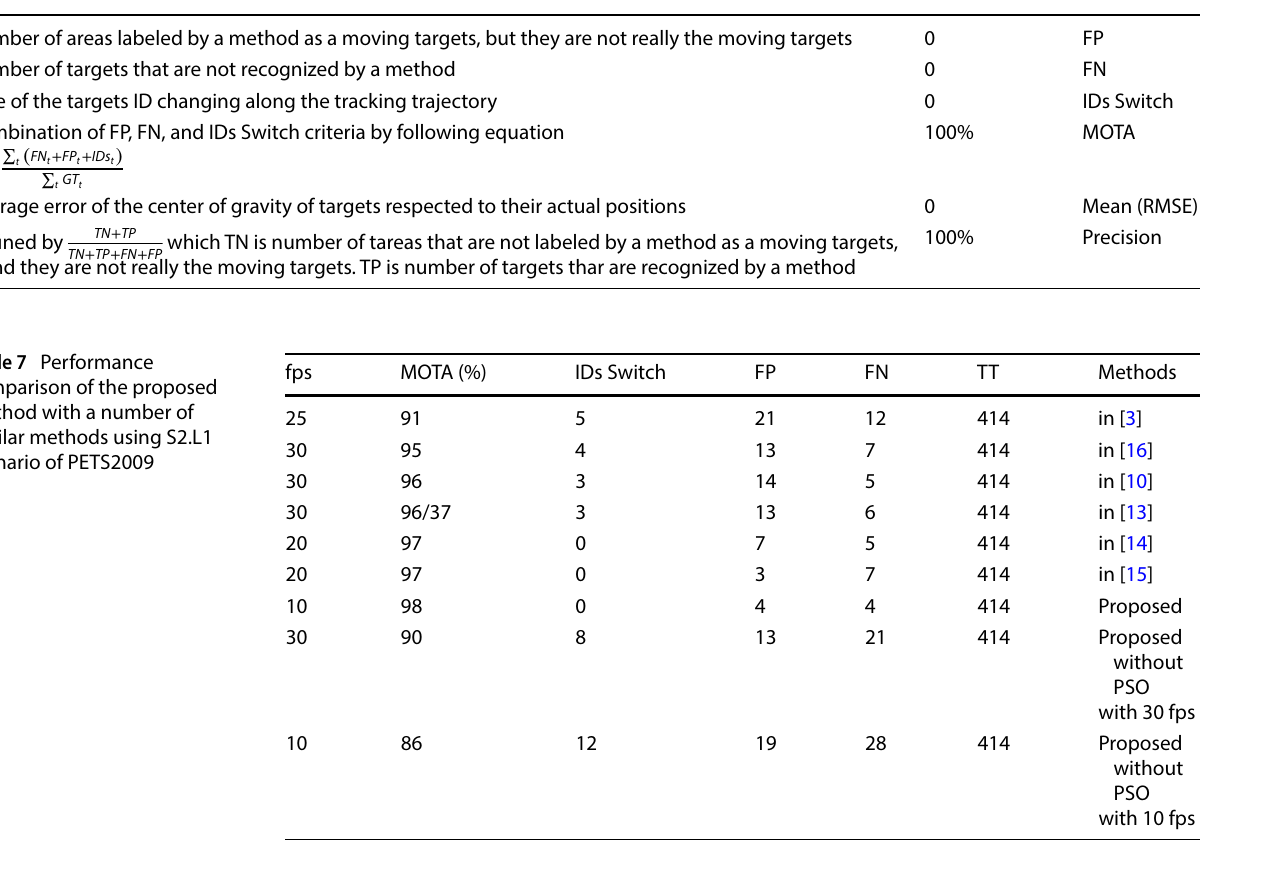
Table 6 Different criteria for the targets tracking evaluation Description